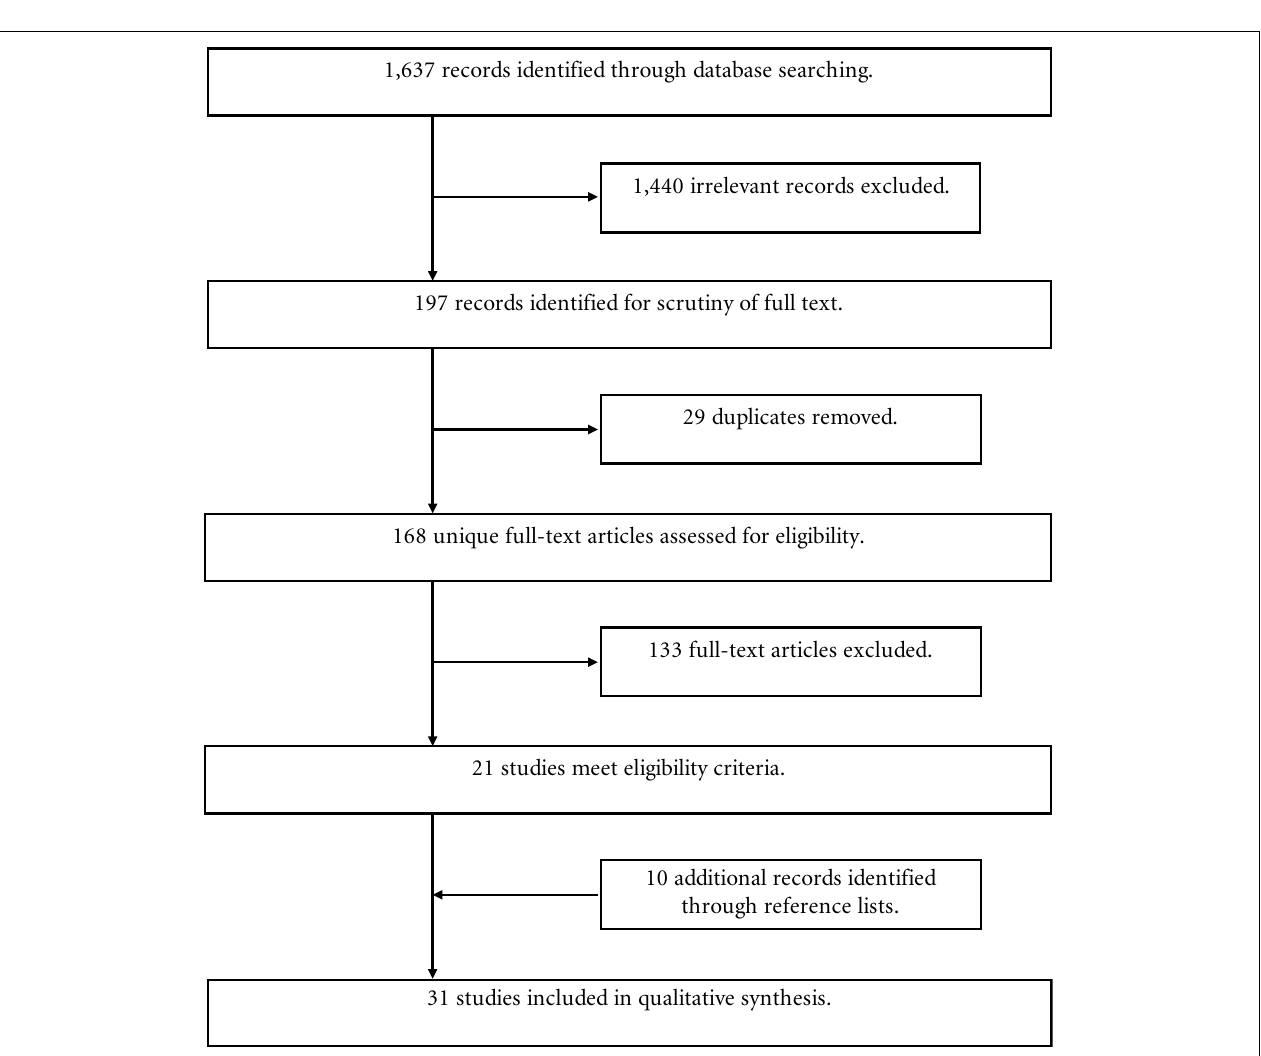
FIGURE 1 | Flowchart of article inclusion procedure during review of the literature . From 1,637 individual records initially identified through the literature search of the Medline, PsychINFO, and Embase databases, 31 articles were included in the final